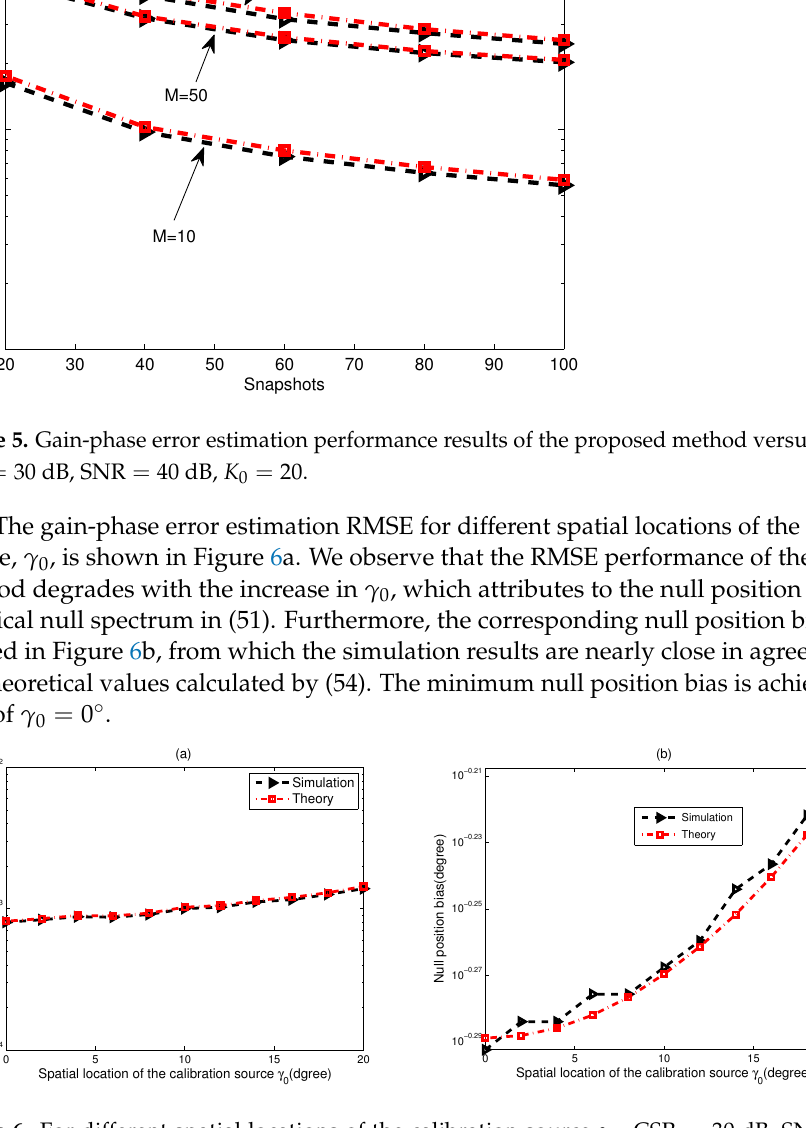
Figure 6. For different spatial locations of the calibration source γ 0 , CSR = 30 dB, SNR = 40 dB, K 0 = 20, T = 80, N = 40. ( a ) Gain-phase error estimation performance results of the proposed method, M = 6. ( b ) Null position bias of the null-spectrum ∆ γ 0 , M =